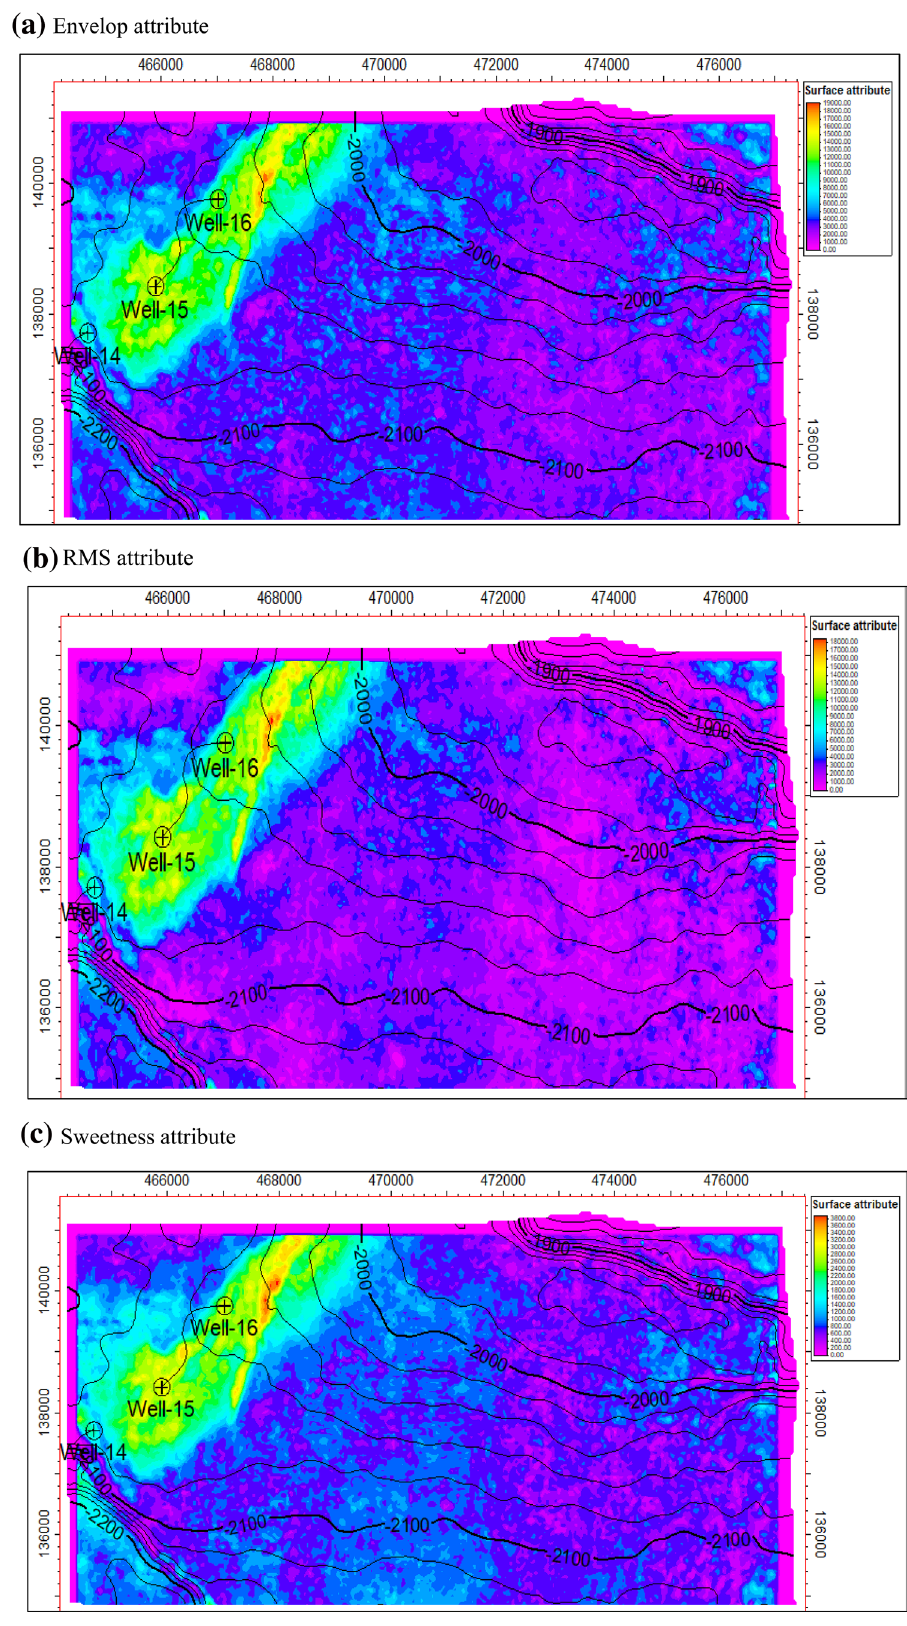
Fig. 9 Amplitude attribute maps for H4